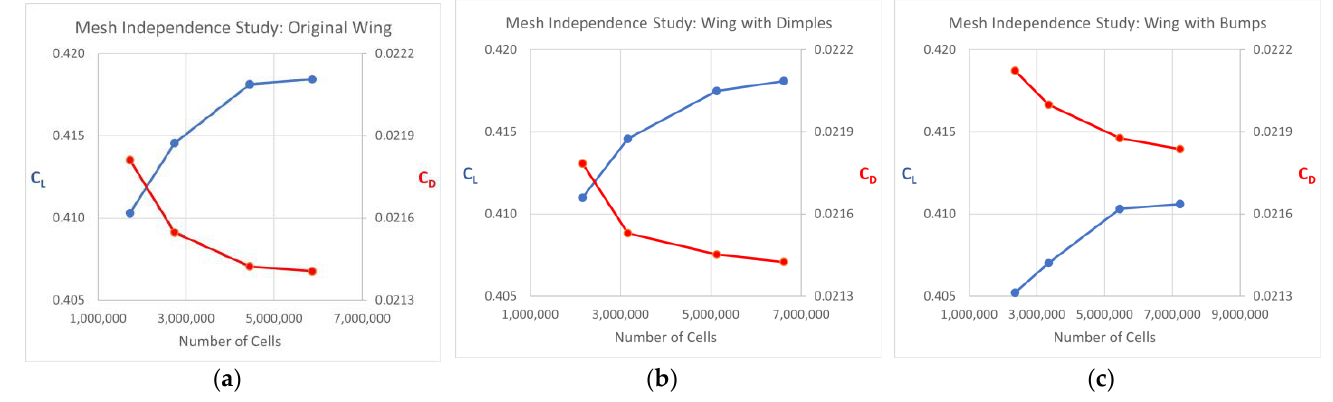
Figure 4. CAD design of the ( a ) bump with a diameter of 2.5 mm and ( b ) dimple with a diameter of 2.5 mm.